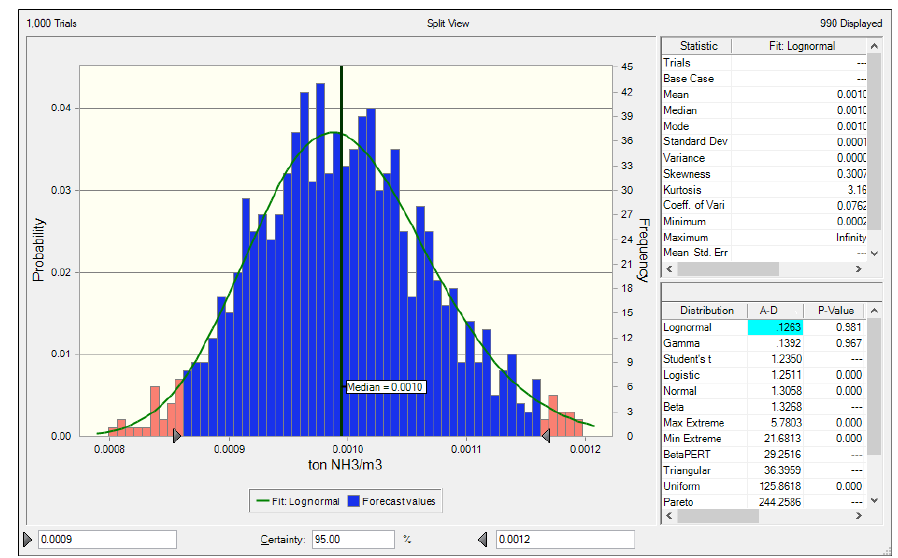
Figure 6. Uncertainty of the NH 3 emission factor at LNG selective catalytic reduction (SCR) outlet.